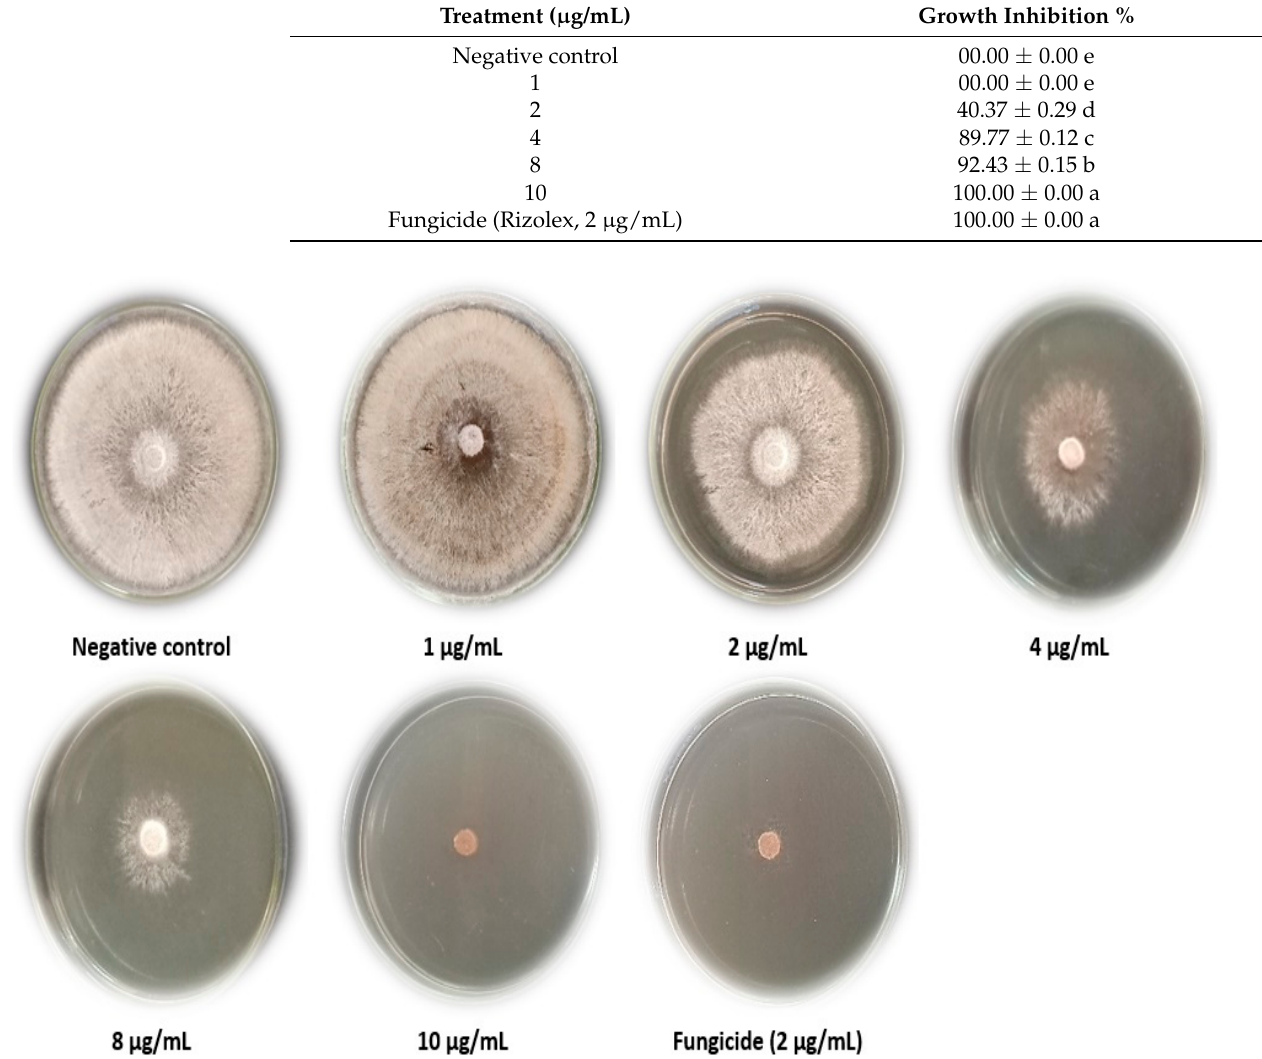
Figure 2. Antifungal activity of different concentrations of Chorisia speciosa extract against Rhizoctonia solani fungus compared with negative control and fungicide (Rizolex).